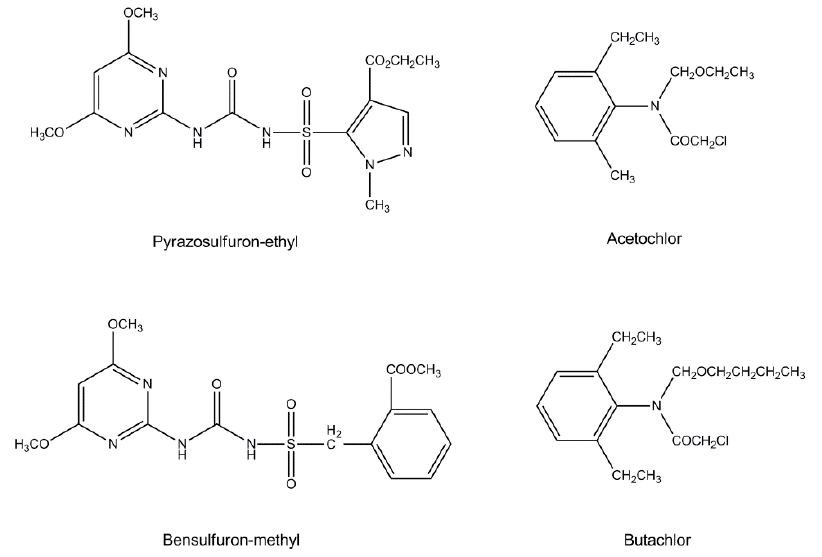
Figure 1. Chemical structures of pyrazosulfuron-ethyl, bensulfuron-methyl, acetochlor, and